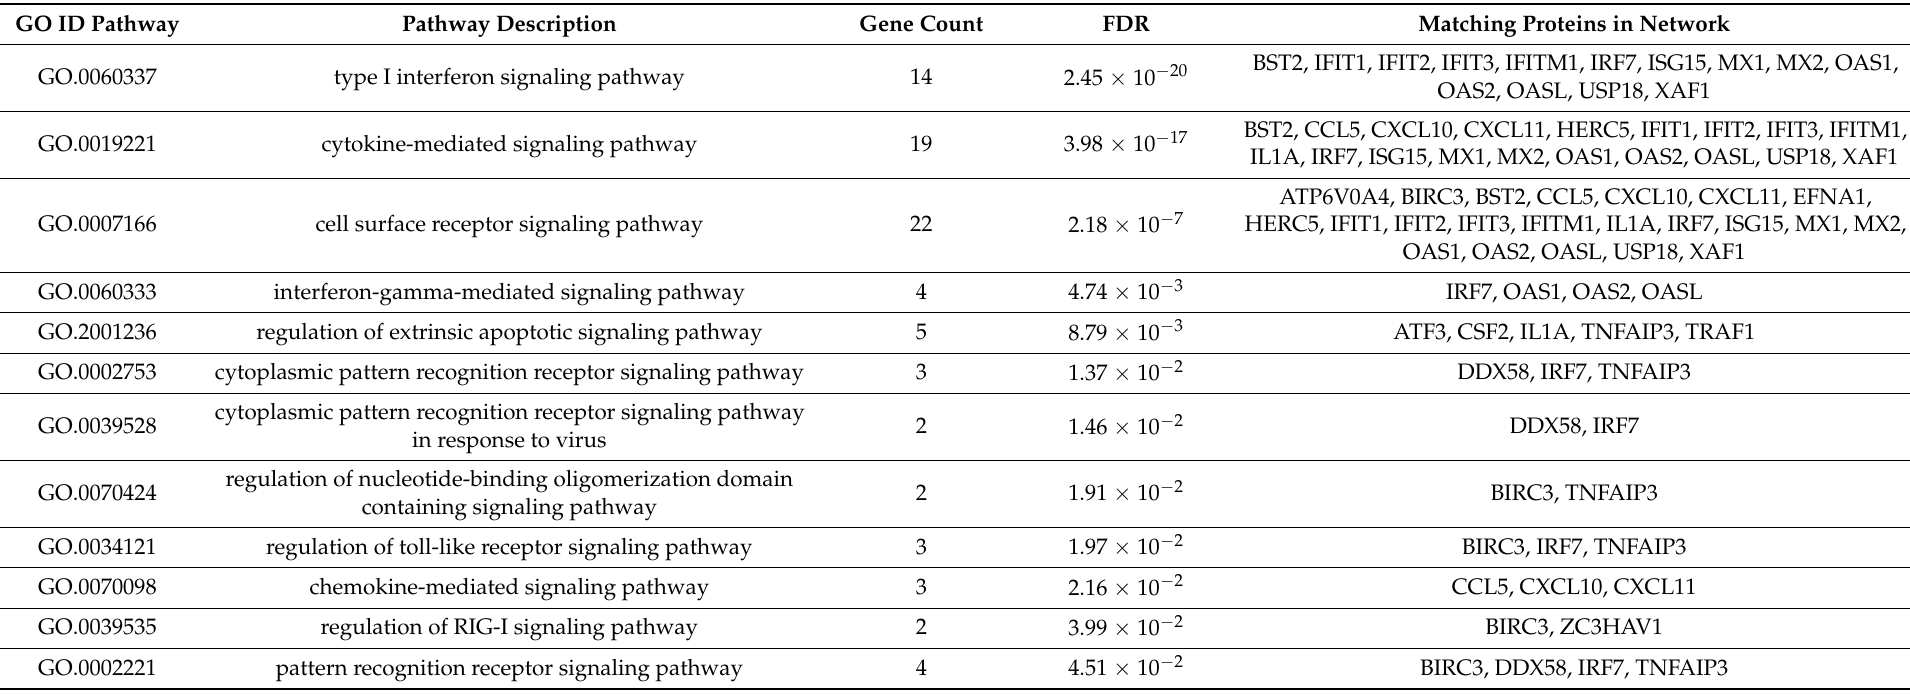
Table 2. GO Biological process enrichment of the Differentially Expressed